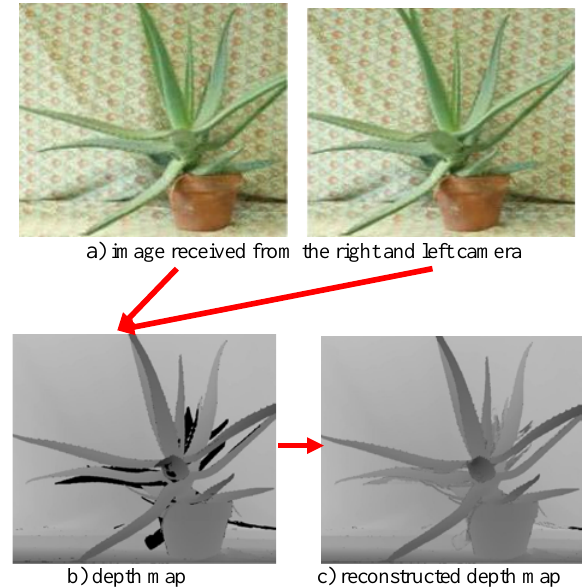
Fig. 6. Processing example.